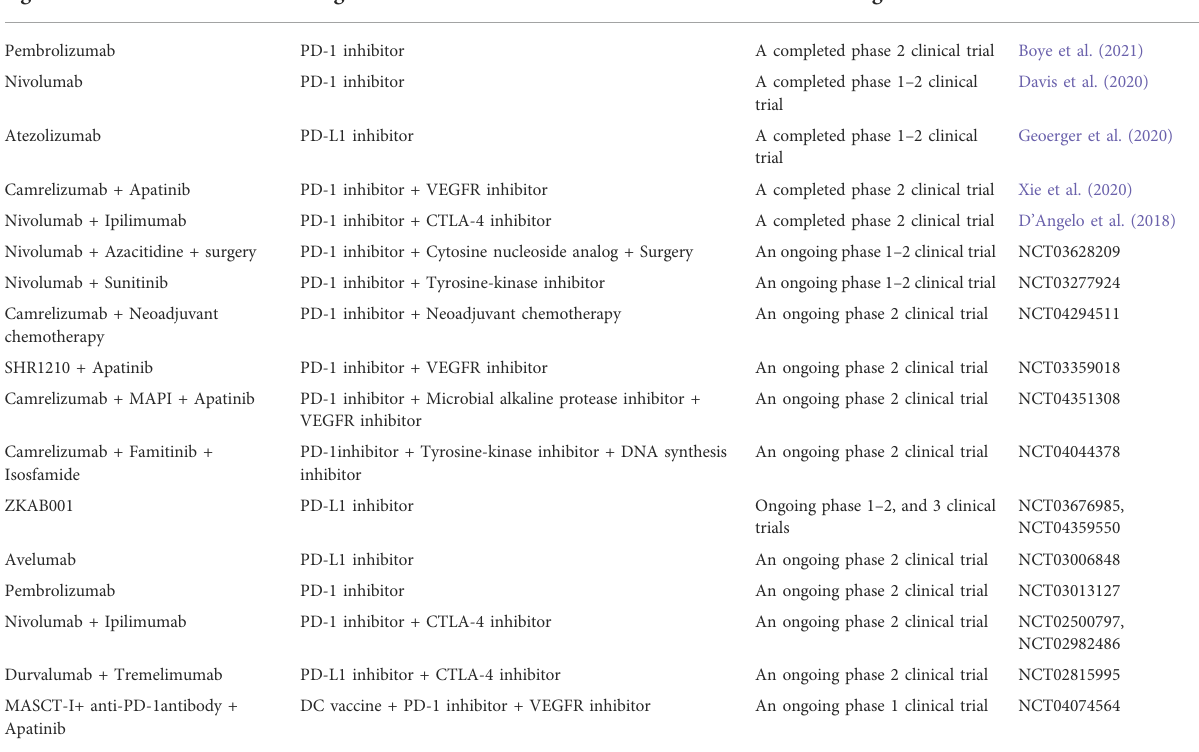
TABLE 1 Current clinical trials of ICIs therapy on